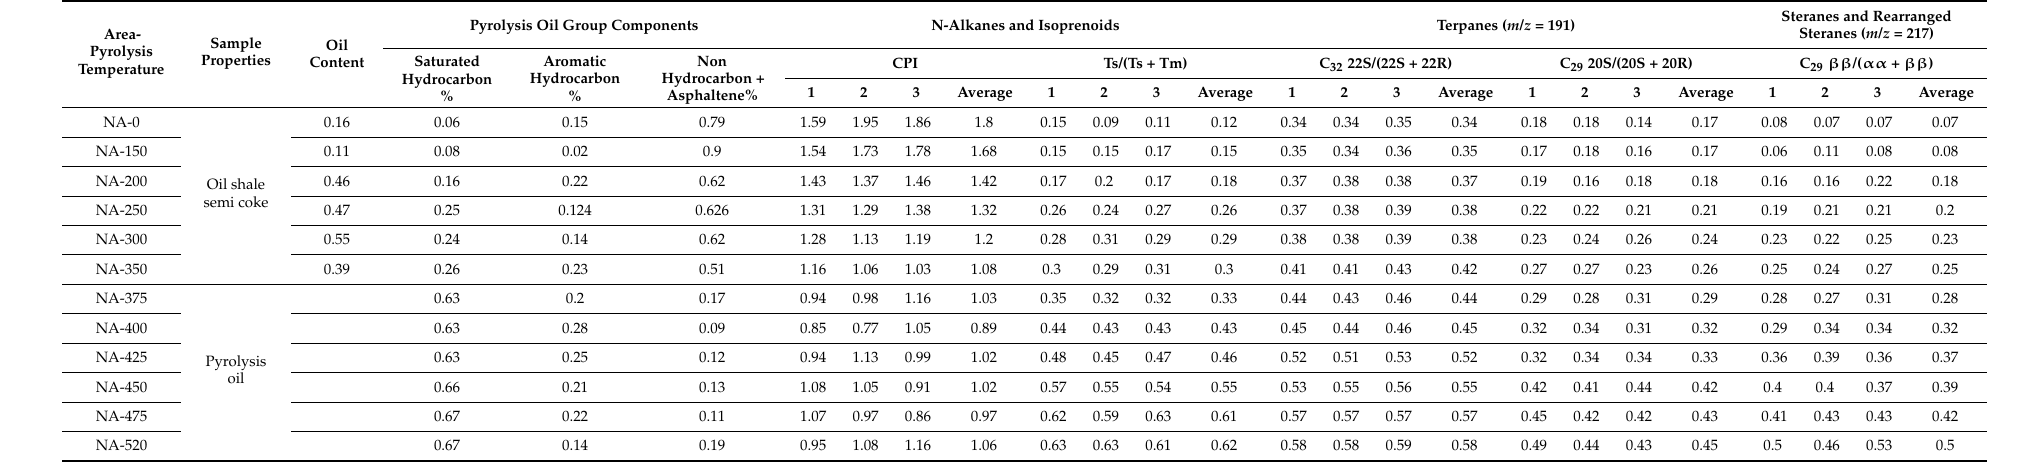
Table 3. Geochemical parameters of Nongan oil shale samples at different pyrolysis